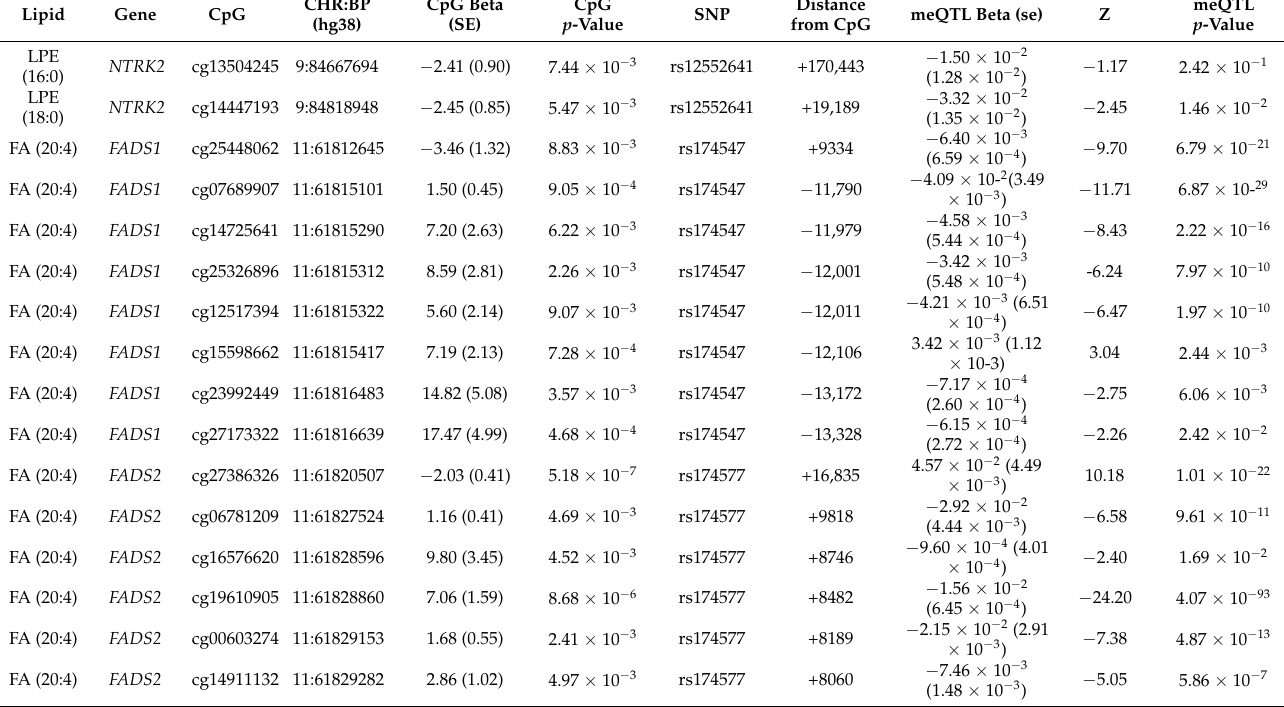
Table 3. Regional CpG-lipid associations and meQTLs in